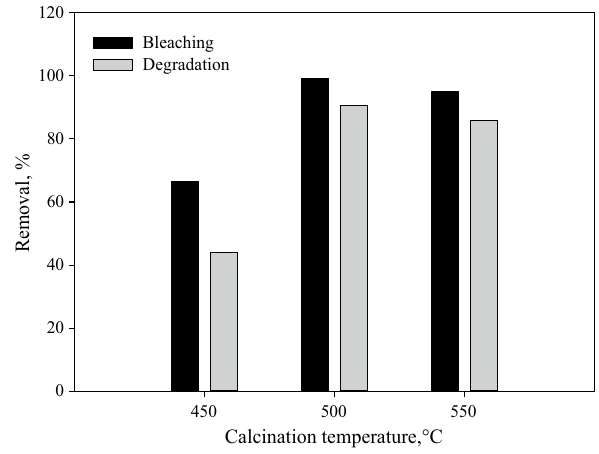
Fig. 14 Effect of calcination temperature on the rate bleaching and dye degradation of MO. pH 6, 20 mg L −1 photocatalyst, methyl